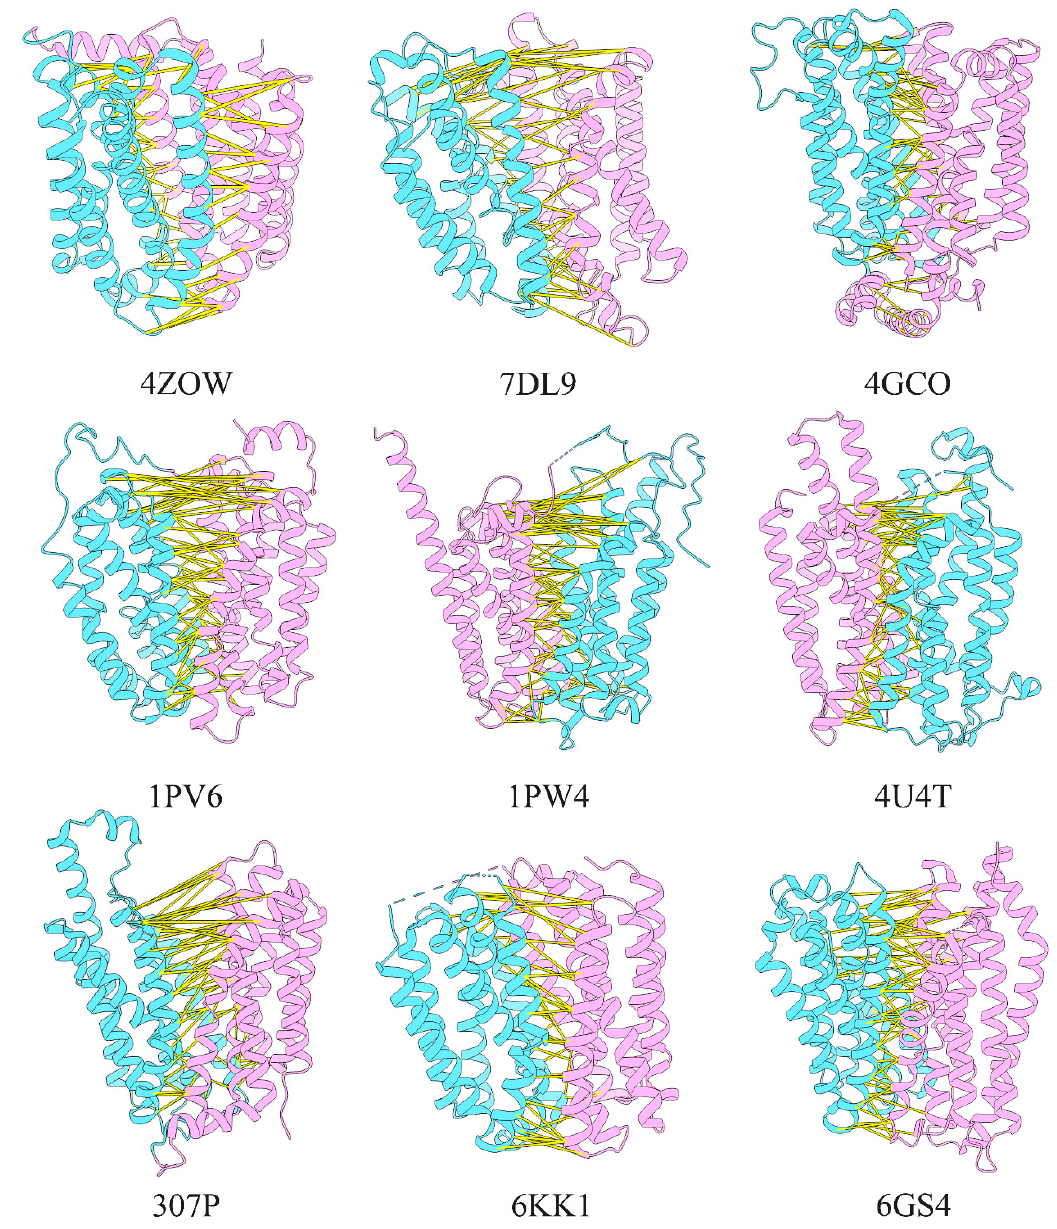
Figure 1. Location of the coevolutionary residue pairs with the Prob score above 0.9 on the interface of N- and C-terminal domains. The yellow stick linked the residue pairs. The N-terminal domain was colored violet, and the C-terminal domain was colored cyan.